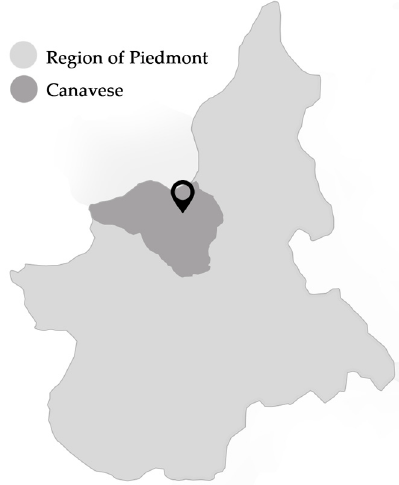
Figure 1. The location of the castle.